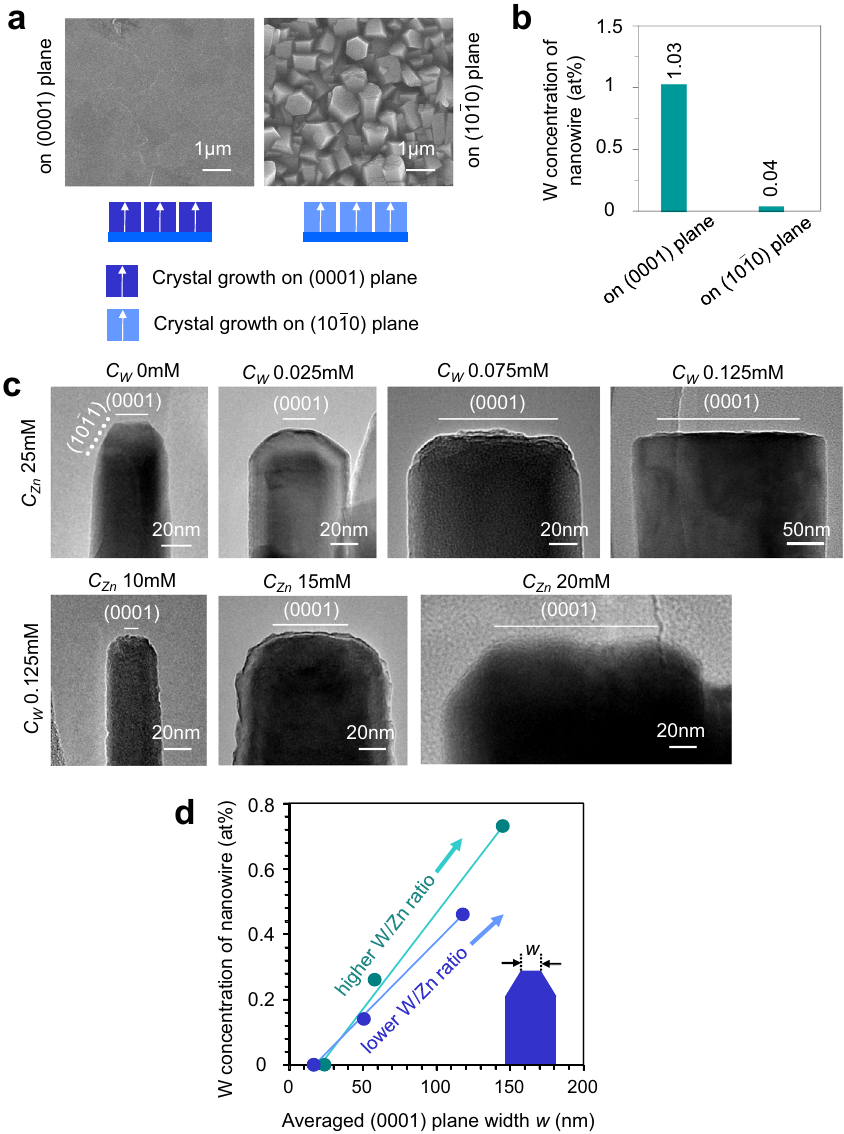
(cid:1) (cid:3) -oriented